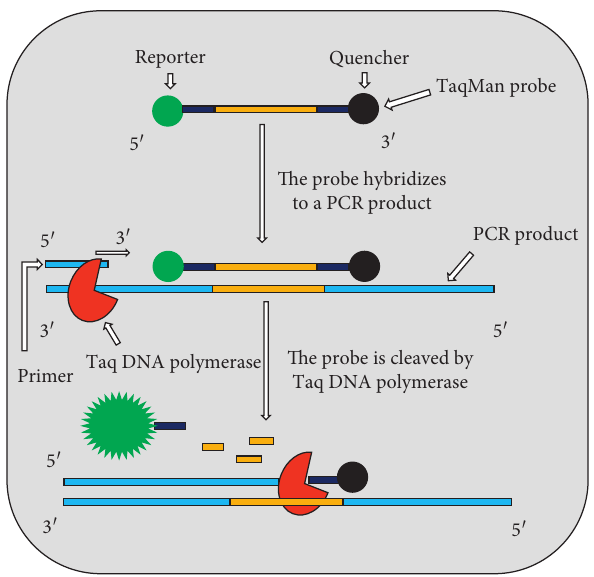
Figure 1: Schematic of the use of TaqMan probe in real-time PCR.